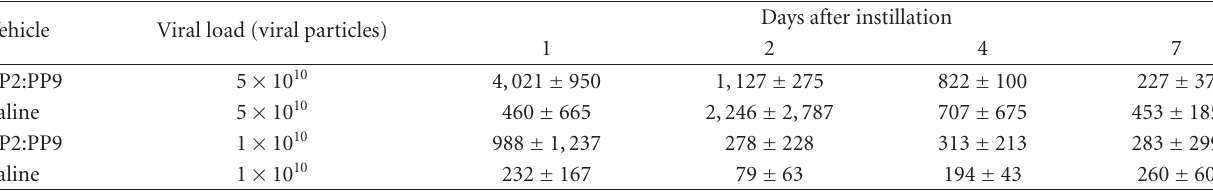
Table 1: Temporal pattern of thoracic luciferase expression.